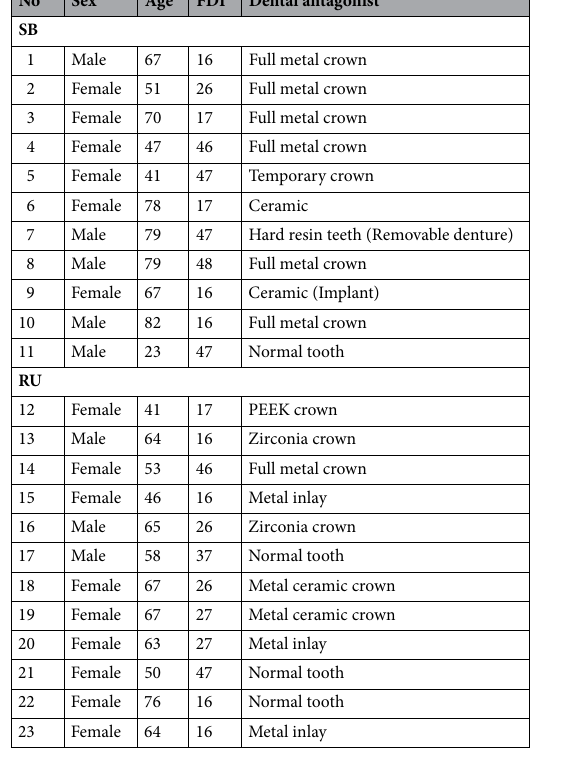
Table 1. Details of data for 20 subjects and 23 PEEK crown cases. SB super-bond C&B, RU relyx ultimate resin